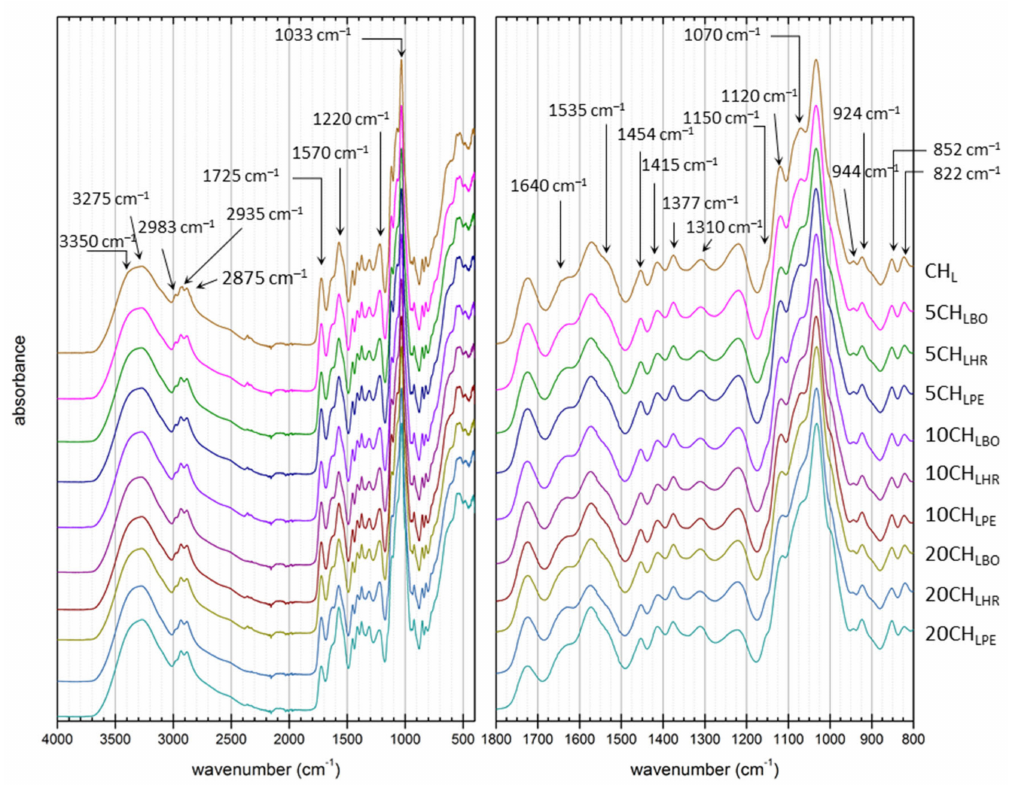
Figure 1. ATR-FTIR spectra of all prepared films. Every spectrum represents an average of spectra recorded separately on six randomly distributed spots of the film surfaces (three on each